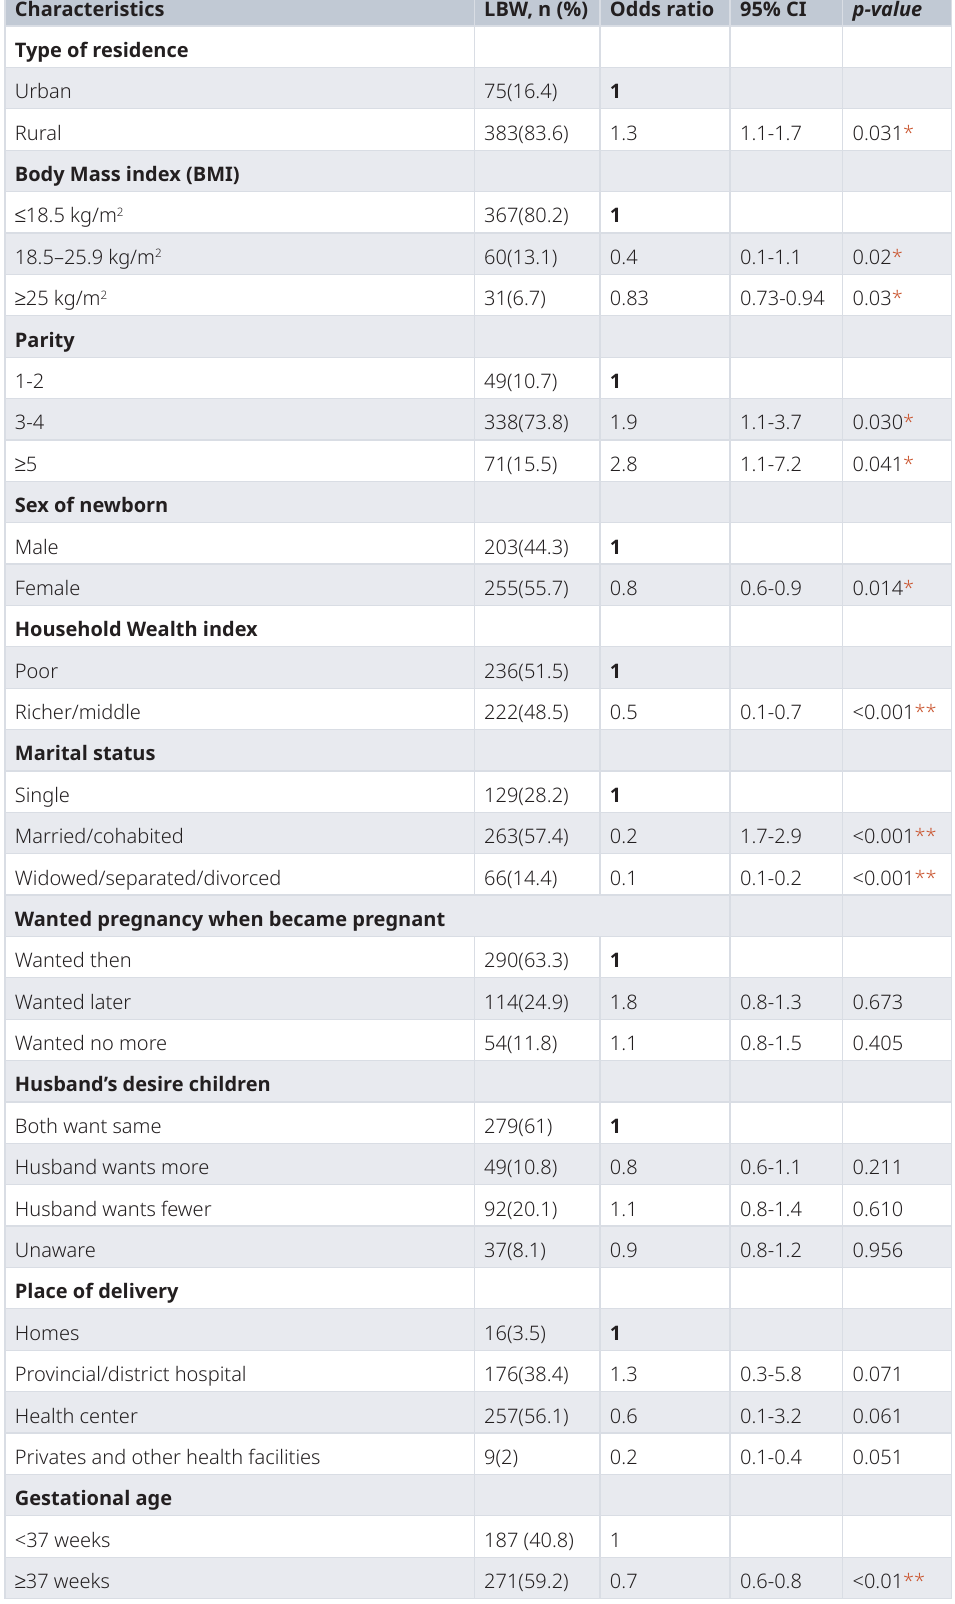
Table 2. Bivariate logistic regression for analysing the association between the independent variables and LBW.